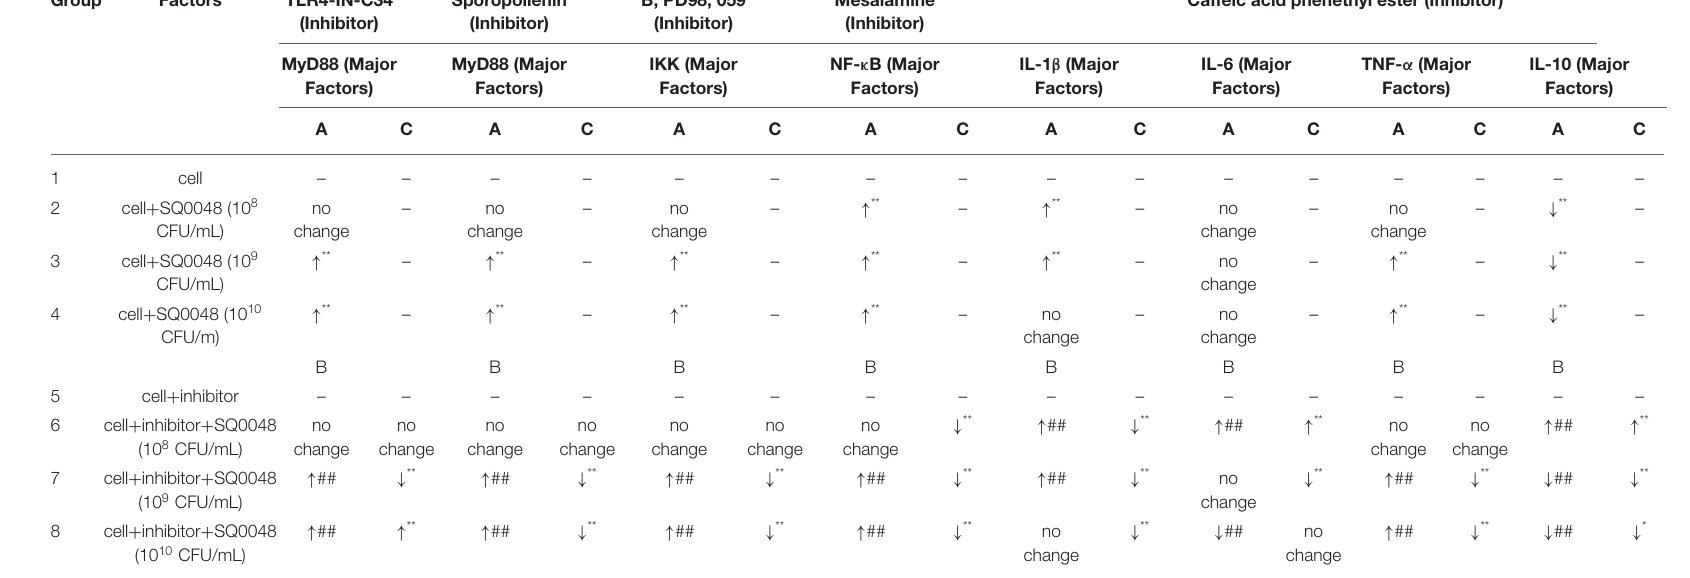
TABLE 1 | Inflammatory factor mRNA levels.